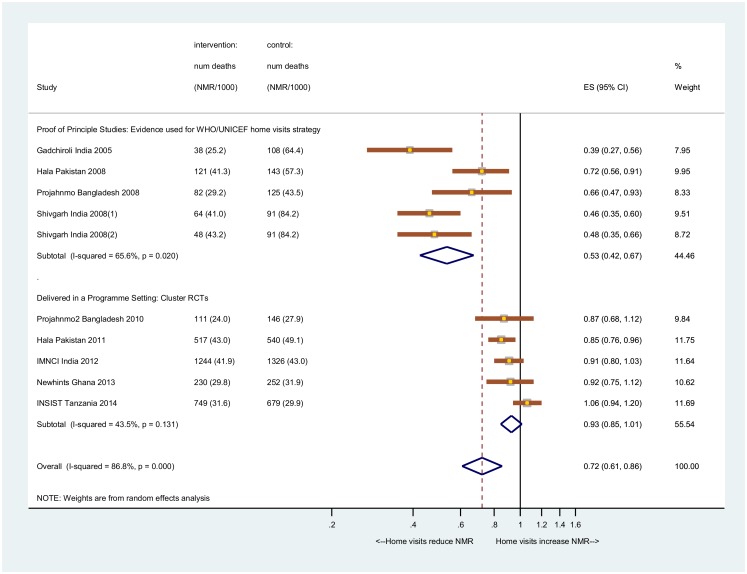
Meta-analysis of the effect of home visits on NMR.Data are the number of deaths (newborn mortality rate per 1,000 live births). Proof-of-principle studies: Gadchiroli, India, 2005 [4]; Hala, Pakistan [7]; Projahnmo, Bangladesh, 2008 [6]; Shivgarh, India, 2008 [5]; Projahnmo-2, Bangladesh [33]; Hala, Pakistan [31], Integrated Management of Neonatal and Childhood Illnesses, India [32]; Newhints, Ghana [9]; and Improving Newborn Survival in Southern Tanzania (INSIST). Shivgarh-1 = home visits only. Shivgarh-2 = home visits plus thermospot.